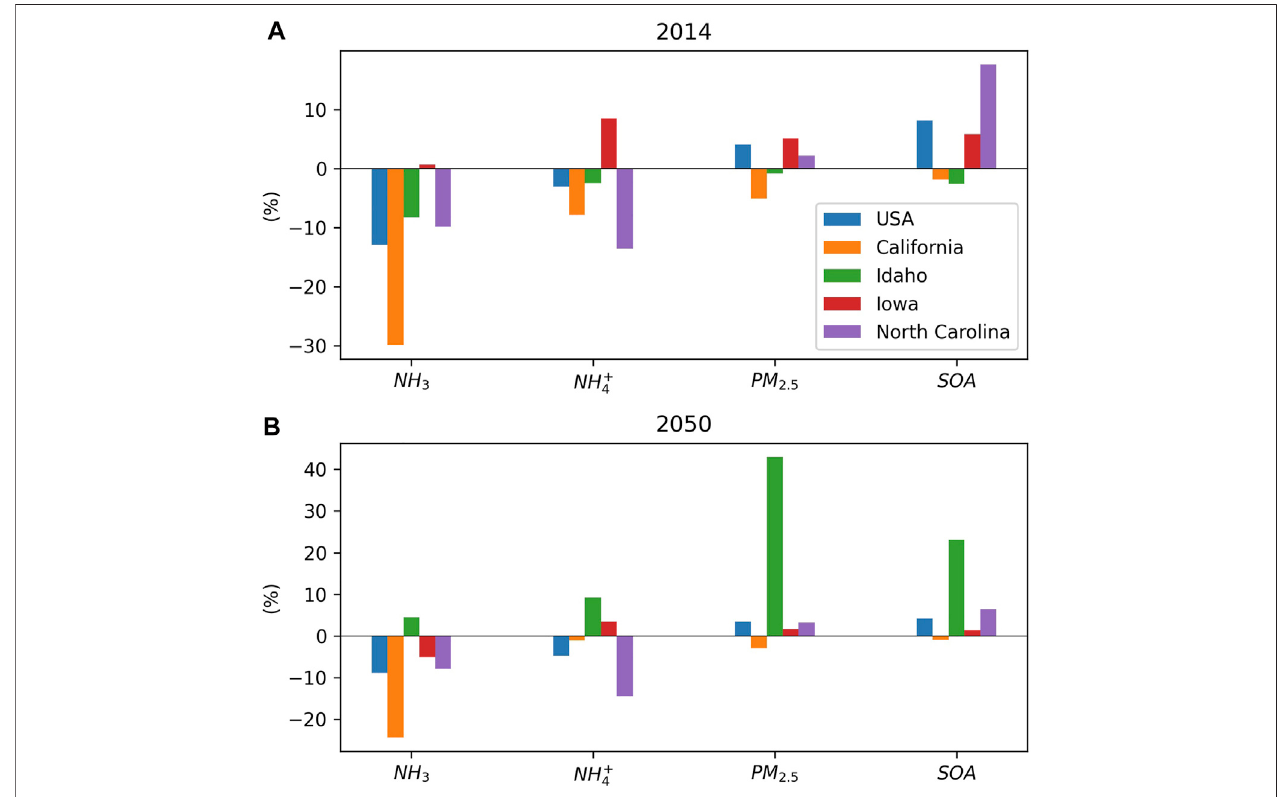
FIGURE3| NormalizedaveragedconcentrationchangesduetotheNH 3 -SOAuptakefortheUnitedStatesandfourstateswithtopanthropogenicNH 3 emissions for the (A) 2014 case and (B) 2050 case.